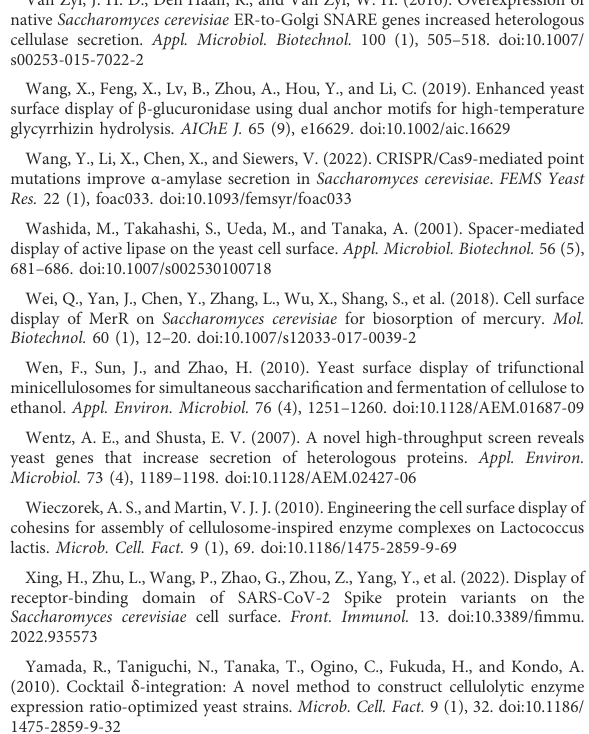
Tabañag, I. D. F., Chu, I. M., Wei, Y.-H., and Tsai, S.-L. (2018). Ethanol production from hemicellulose by a consortium of different genetically-modi fi